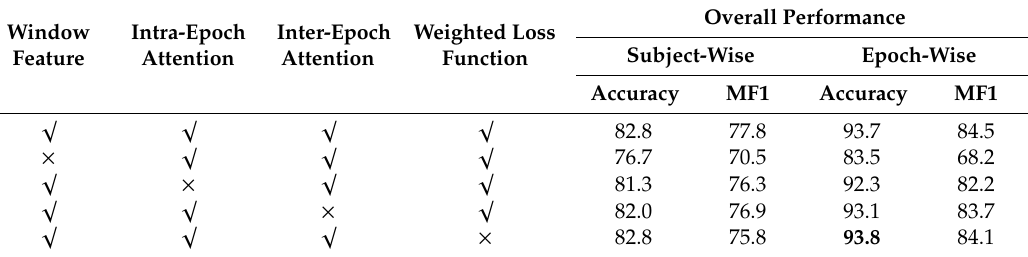
Table 5. Performance of different combinations of model components.